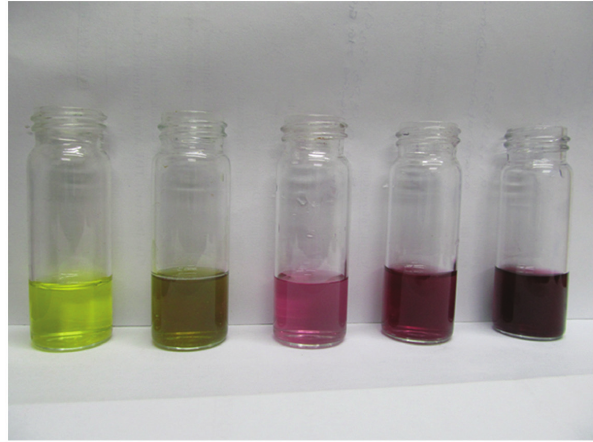
Figure 1 Color change denoting the formation of gold nanoparticles.